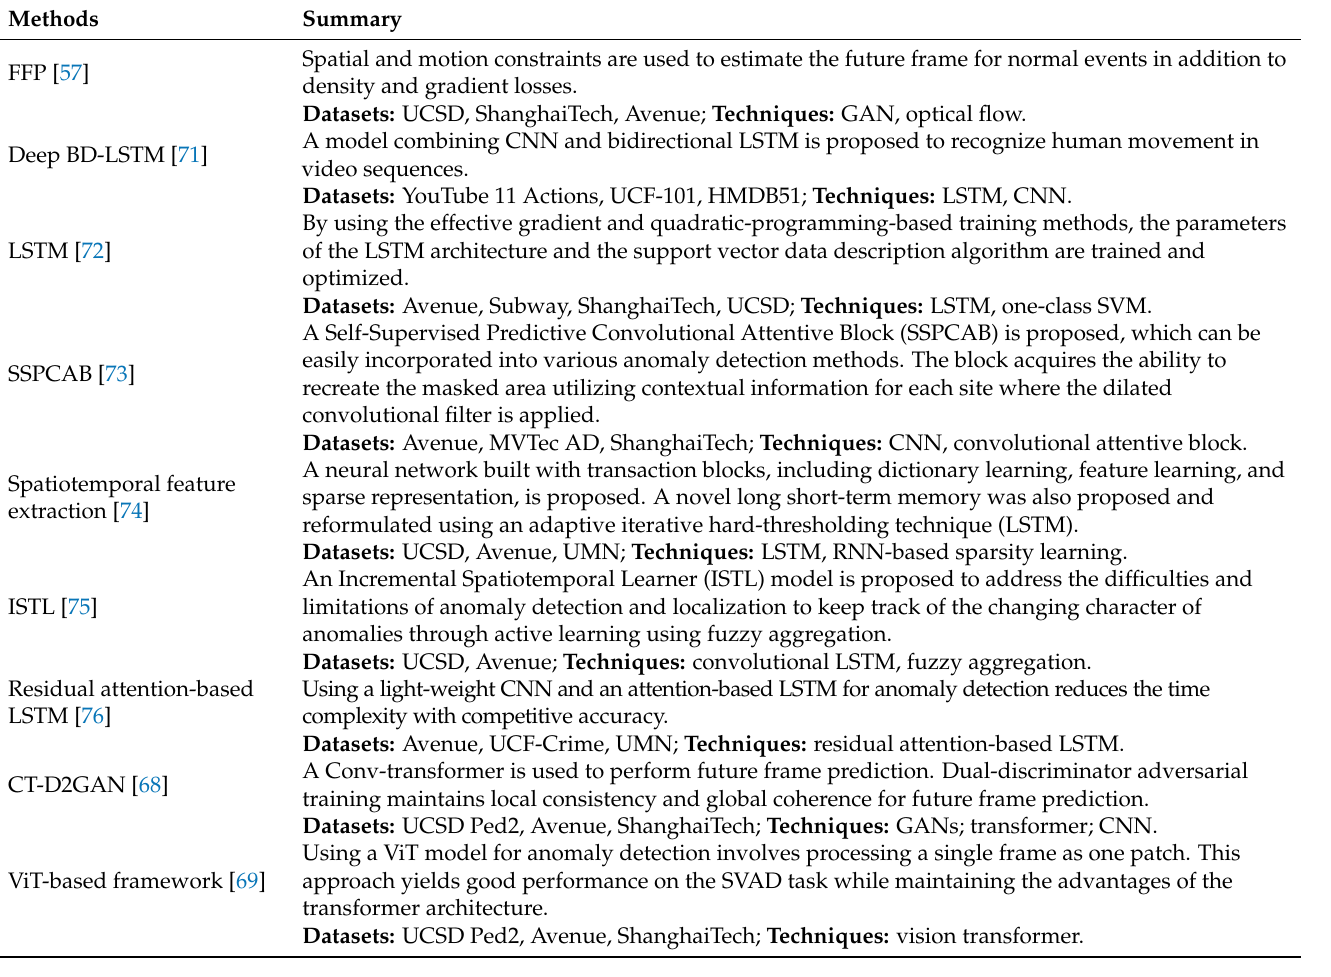
Table 5. Prediction-based